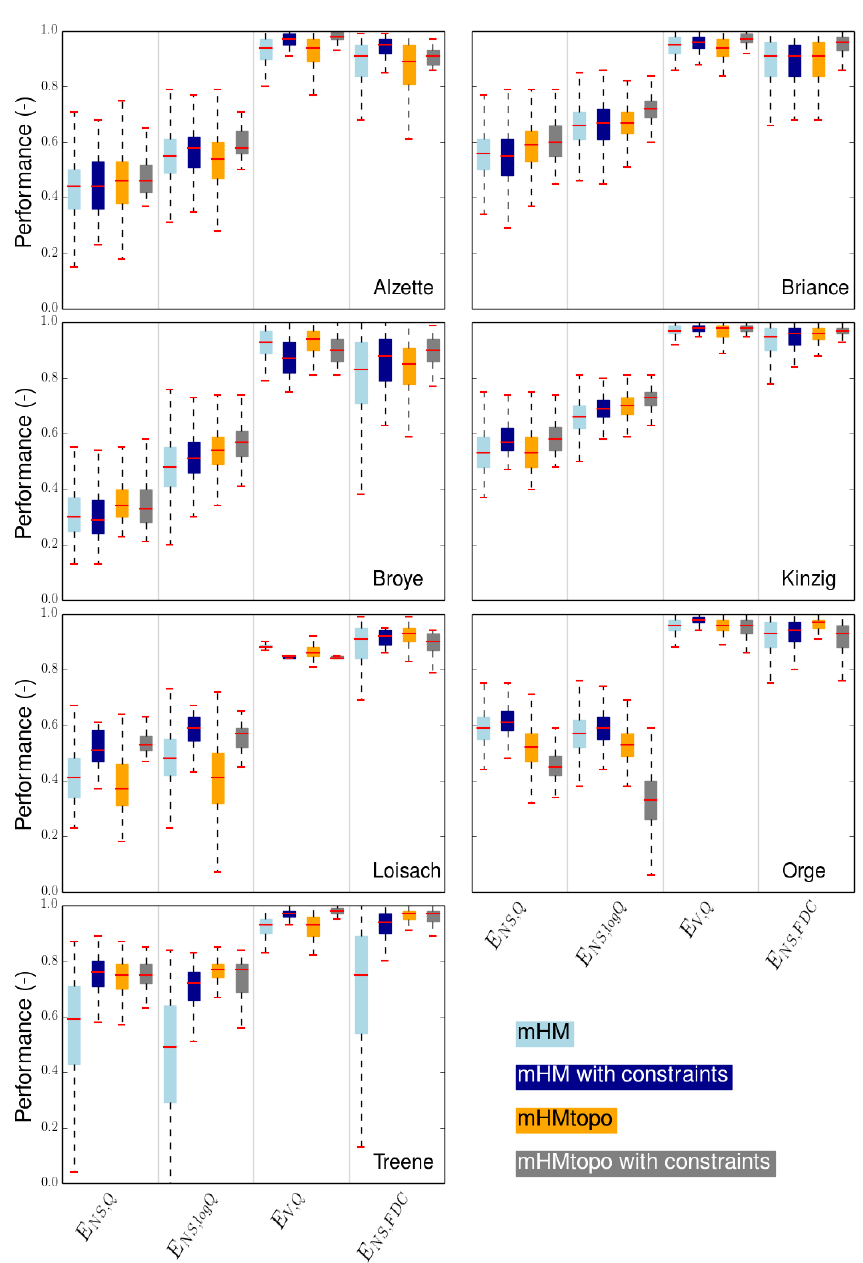
Figure 6. Nash–Sutcliffe efficiency ( E NS , Q ), log Nash–Sutcliffe efficiency ( E NS , logQ ), volume error ( E V , Q ) and log Nash–Sutcliffe effi- ciency of the flow duration curve ( E NS , FDC ) for the seven catchments in the validation periods. The optimal value for all four criteria is 1, whereas 0 is regarded as having a low performance. The boxplots are formed by the Pareto space spanned by the four objective